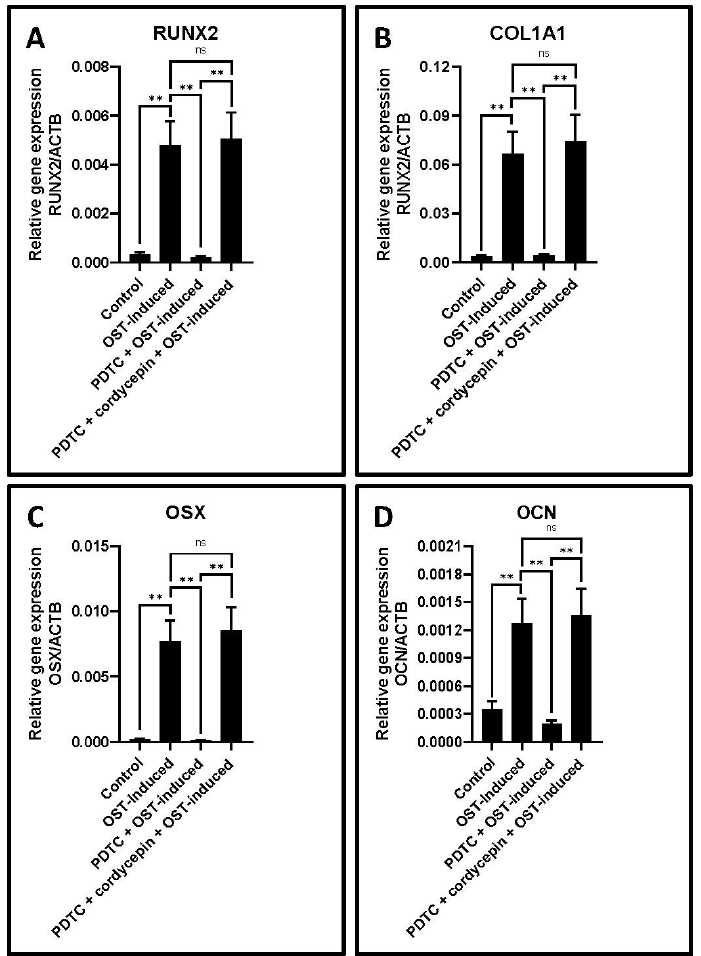
Figure 3. Osteogenic differentiation of DPSCs, quantification of mineralization, and alkaline phosphatase activity. ( A – H ) Osteogenic differentiation was induced in DPSCs with and without treatment with cordycepin and inhibition of osteo- genesis was induced with PDTC. Functional staining was done with alizarin red S. Scale bar = 100 μm, (I) Comparative quantification of mineralization with and without cordycepin treated osteogenesis induced and osteogenesis inhibited DPSCs. ( J ) Comparative alkaline phosphatase activity with and without cordycepin treated osteogenesis induced and osteogenesis inhibited DPSCs. ns not significant, * p < 0.05, ** p < 0.01. OST-induced: osteogenic induction, Cpn: cordycepin.